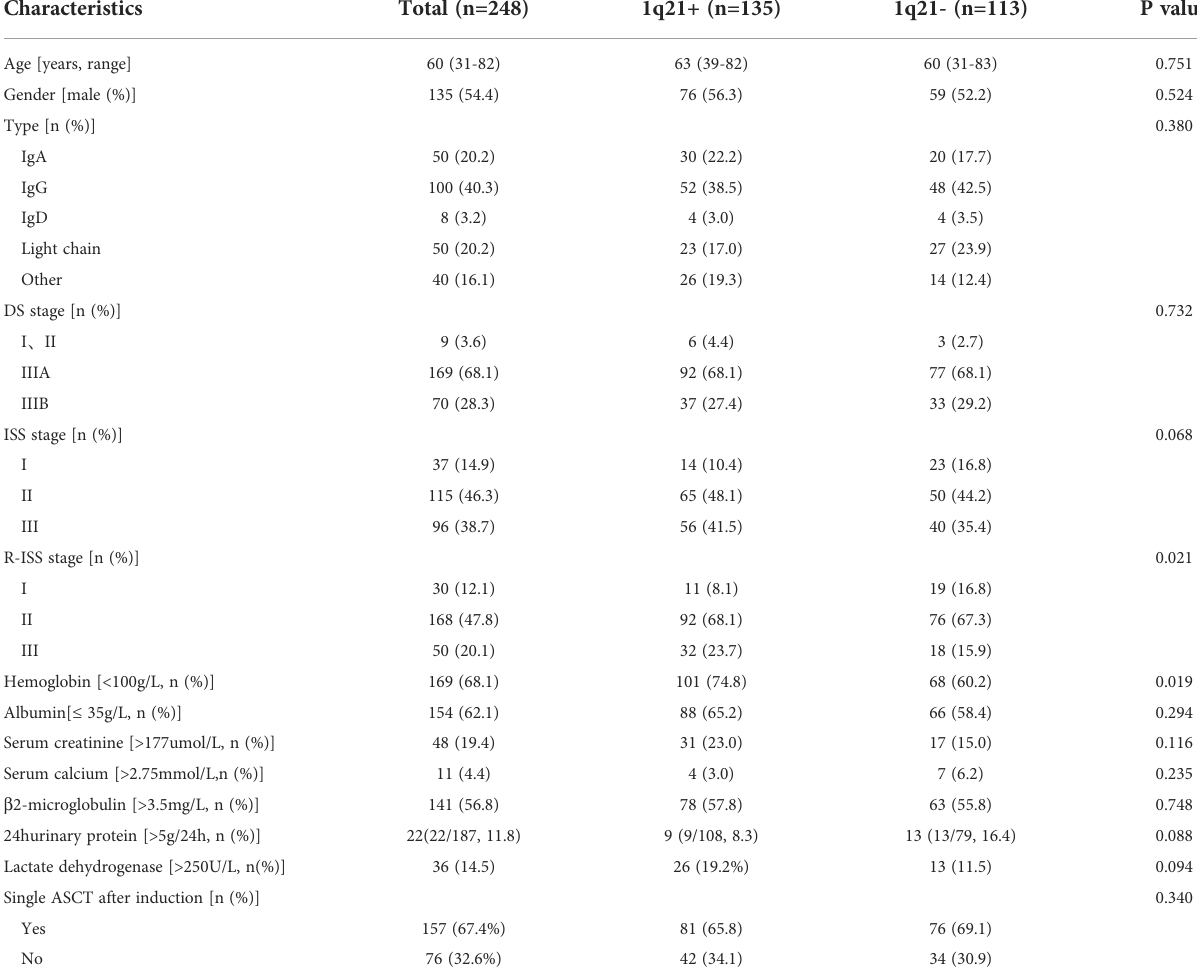
TABLE 1 Clinical and biological characteristics of total patients and 1q21+ patients.